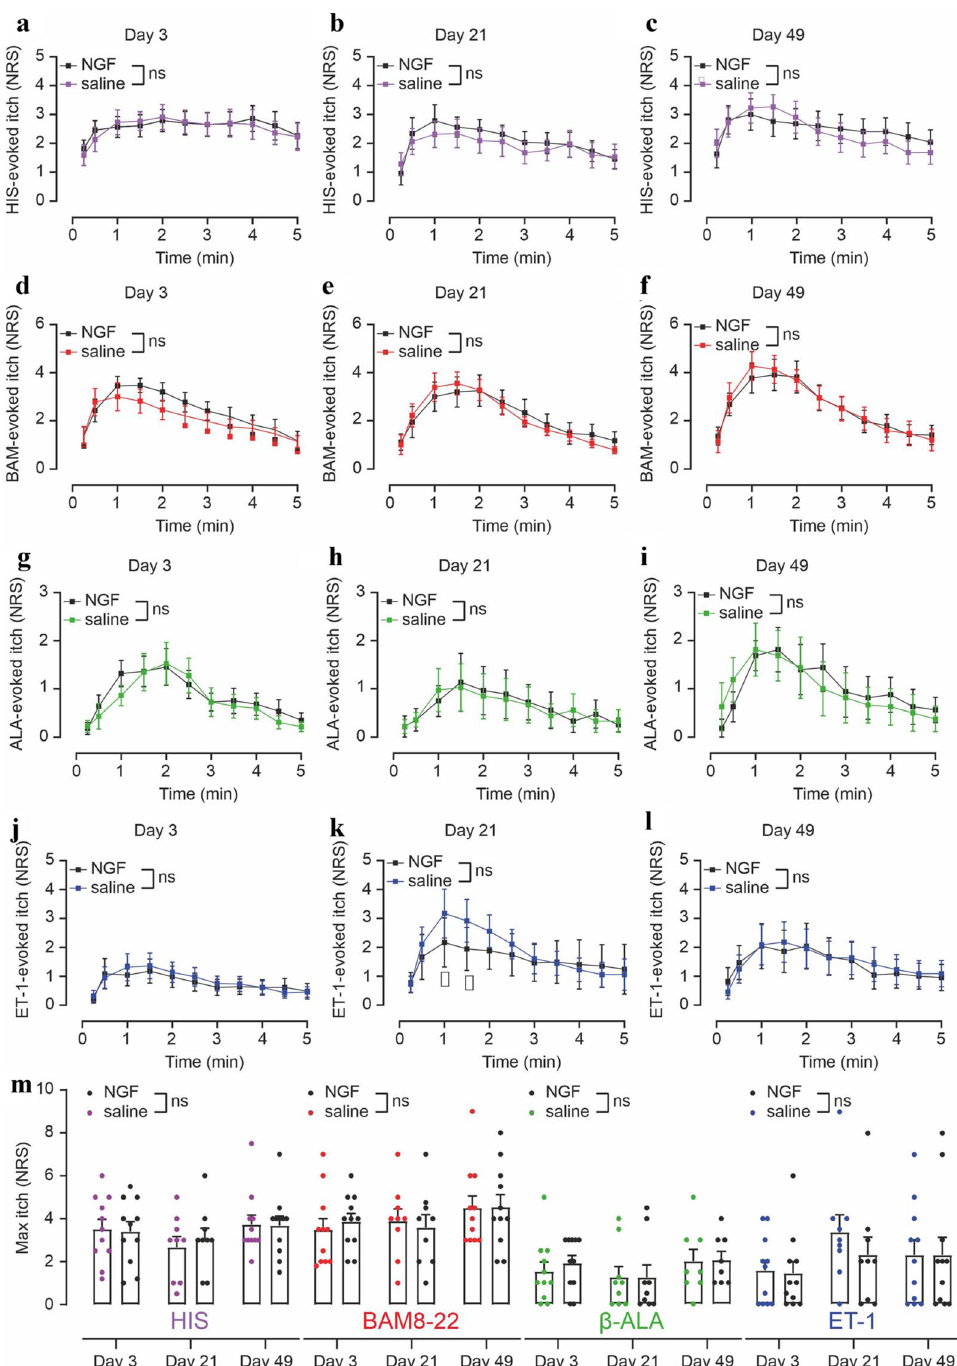
Figure 3. rhNGF does not sensitize itch to BAM8–22, β-ALA and ET-1. ( a–l ): Itch ratings (NRS, 0–10) upon HIS ( a–c ), BAM8–22 ( d–f ), β-ALA ( g–i ), and ET-1 ( j–l ) recorded for 5 min at 3 days (n = 11), 21 days (n = 9) and 49 days (n = 11; n = 8 for β-ALA) post injection of rhNGF (black symbols) and saline (colored symbols), respectively. Overall, significant differences between the rhNGF- and saline-treated sites were not detected (n.s.). Asterisks indicate significant interaction “rhNGF vs saline” × “time” after ET-1 injection (p < 0.001). Data are depicted as mean ± standard error (SEM). ( M ) Maximum itch recorded during the 5-min observation period did not indicate a significant difference between rhNGF and saline at any day of the observation (n.s.). Data presented as mean ± standard error (SEM) with overlay of individual data